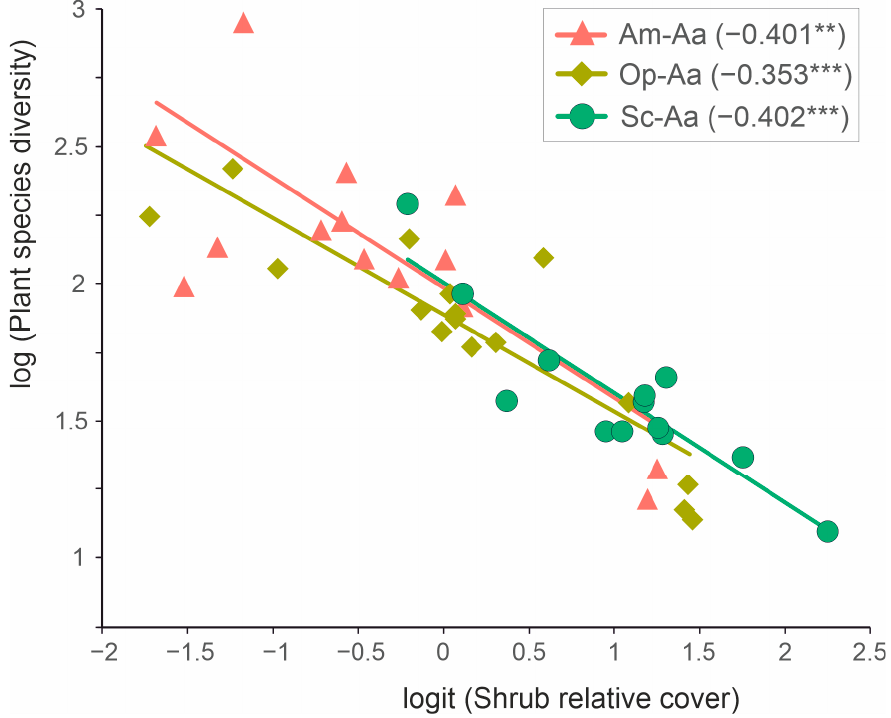
Figure 7. Spatially conditioned linear fit of (log-transformed) species diversity against (logit- transformed) shrub relative cover in each of the three Artemisia alba -(co)dominated communities distinguished in the Carpathian and Pontic regions. The numeric values between parentheses represent the slopes of the fitted lines (0.001 < p ** < 0.01; p *** < 0.001). Abbreviations as in Figure